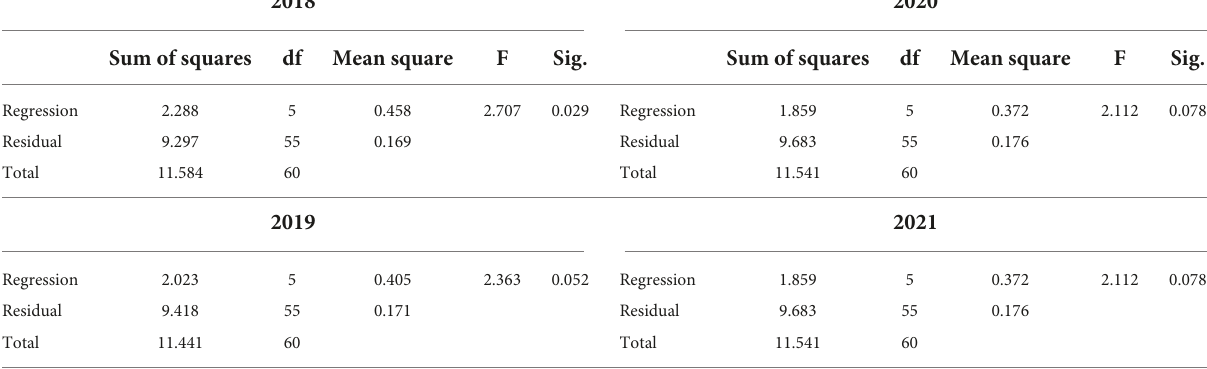
TABLE 6 ANOVA (main market).